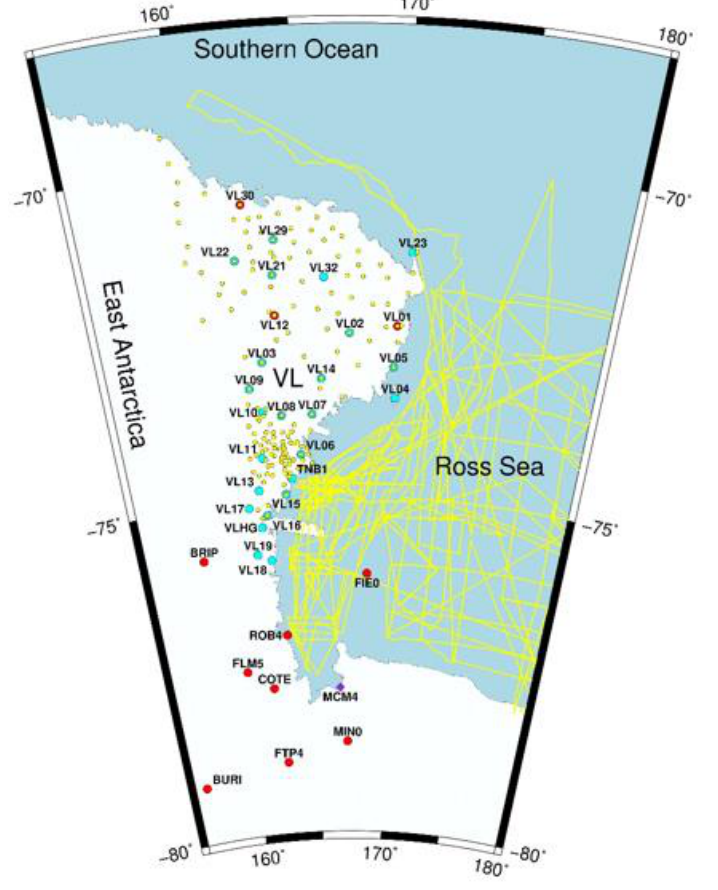
Figure 1. ( A ) Geographical distribution of the Global Navigation Satellite Systems (GNSS) stations used for estimating the Eulerian Pole (VLNDEF18), [14], 95 of which are in Antarctica. Victoria Land (VL), the object of this study, is represented in a black frame, bottom-right inset. Yellow triangles identify the International GNSS Service (IGS) stations adopted to frame the network within the ITRF14 datum; IGS, POLENET, and VLNDEF GNSS stations are respectively represented by purple diamonds, red and cyan circles; blue and orange stars in the bottom of the figure show VLNDEF18 and VLNDEF20 (proposed in this work) Euler poles. ( B ) Map of VL shows the 36 GNSS stations used in this work and the location of the gravimetric data collected during the last 20 years within the PNRA projects. Yellow circles identify the locations of terrestrial gravimetric measurements; yellow polylines show the tracks of shipborne gravimetric data acquisition; red and cyan circles identify POLENET, and VLNDEF GNSS